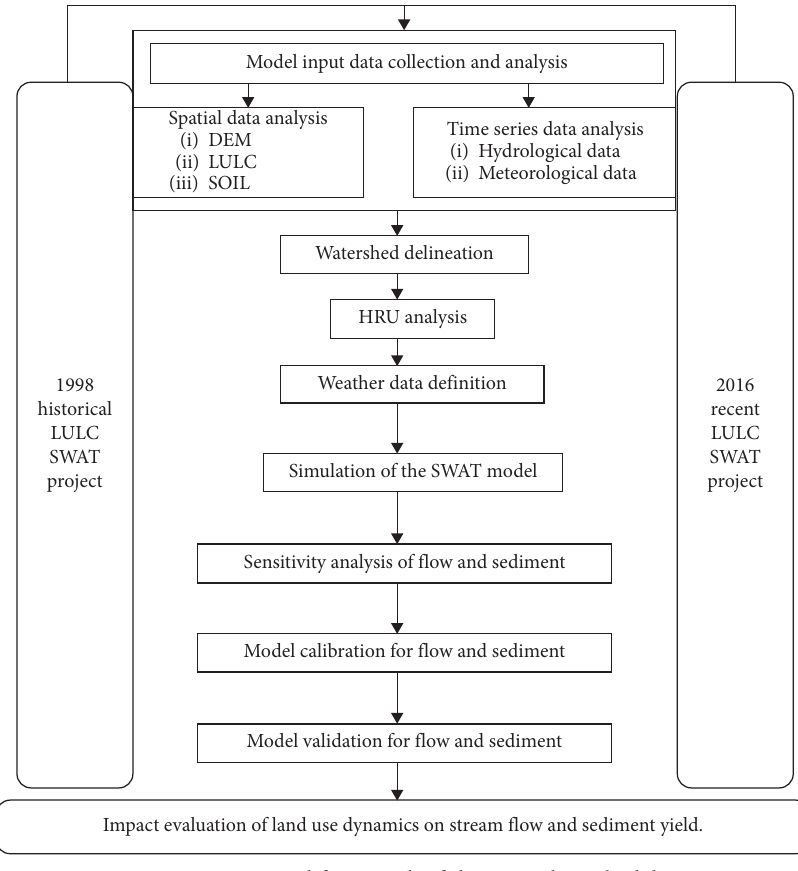
Figure 4: Conceptual framework of the research methodology. Table 1: Area weightage of rainfall